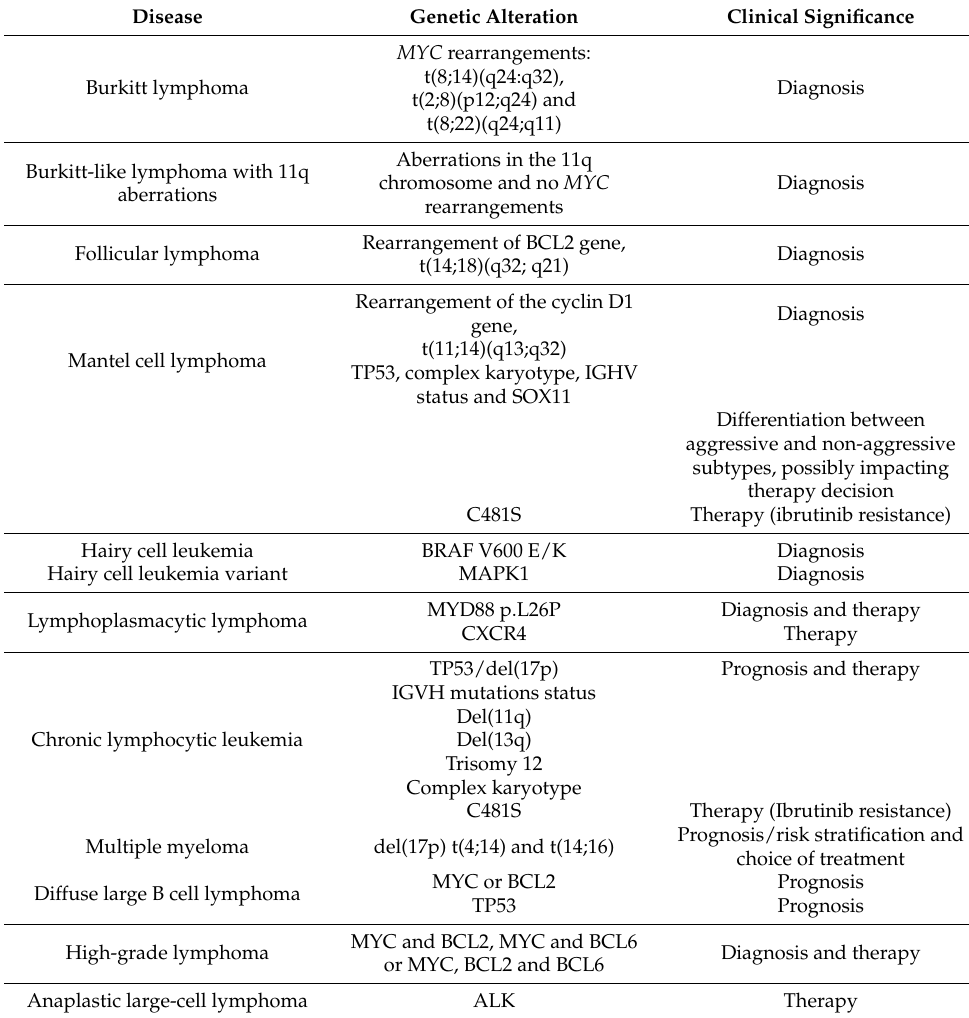
Table 1. Genetic alterations with consolidated clinical implications in